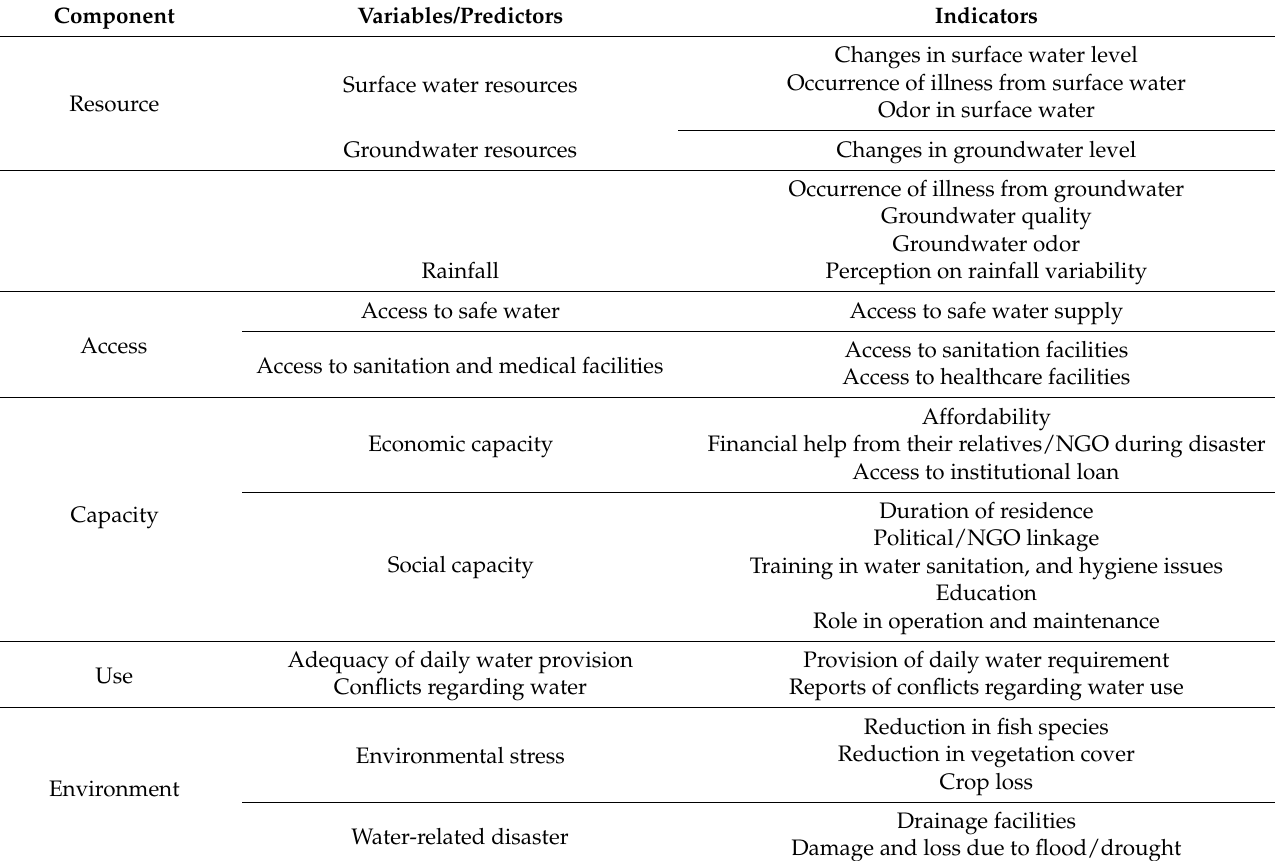
Table 4. Variables and indicators for the multiple linear regression